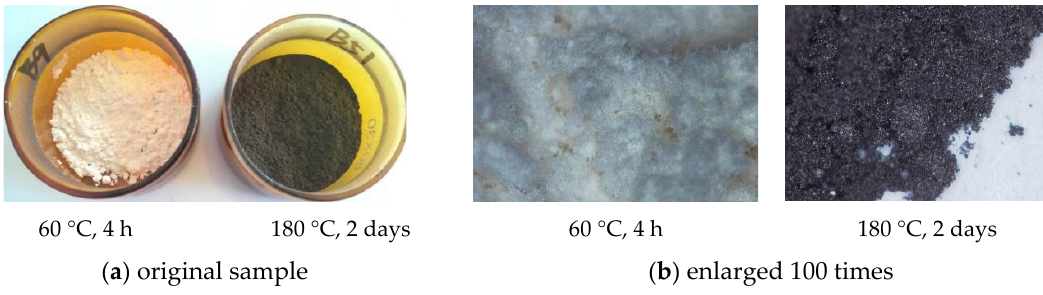
Figure 3. The apparent morphology of magnesium powder before and after different temperature tests.